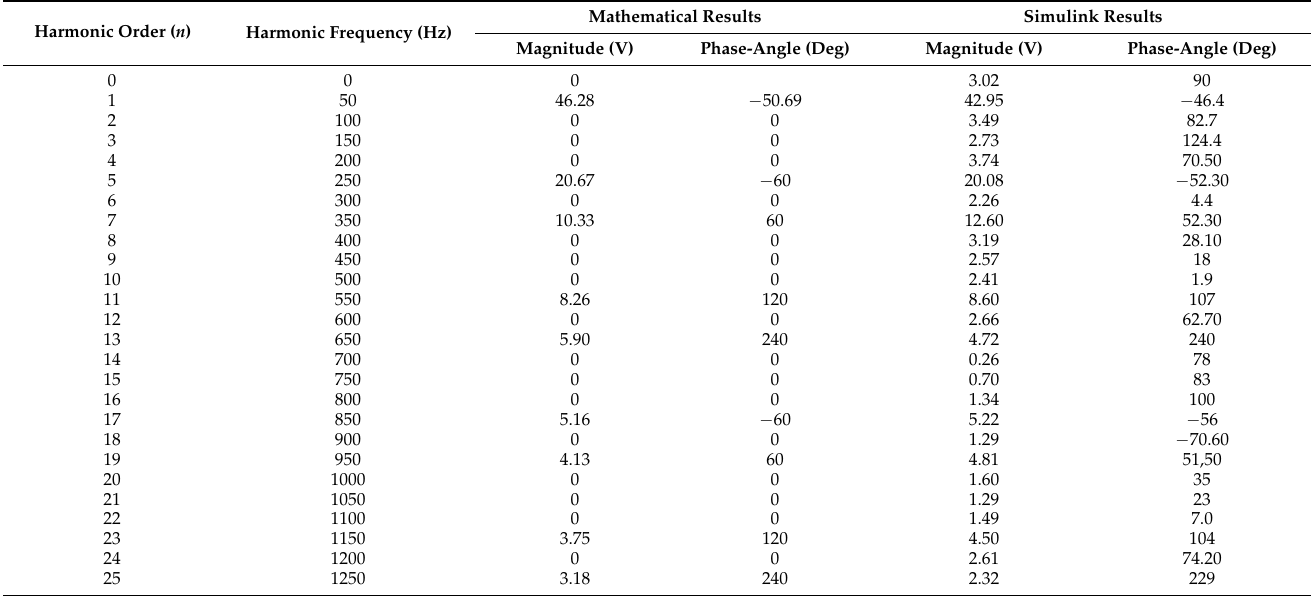
Table 7. Harmonic coefficients of one phase of a three-phase AC voltage controller with a 90° fir- ing delay without wave shifting.